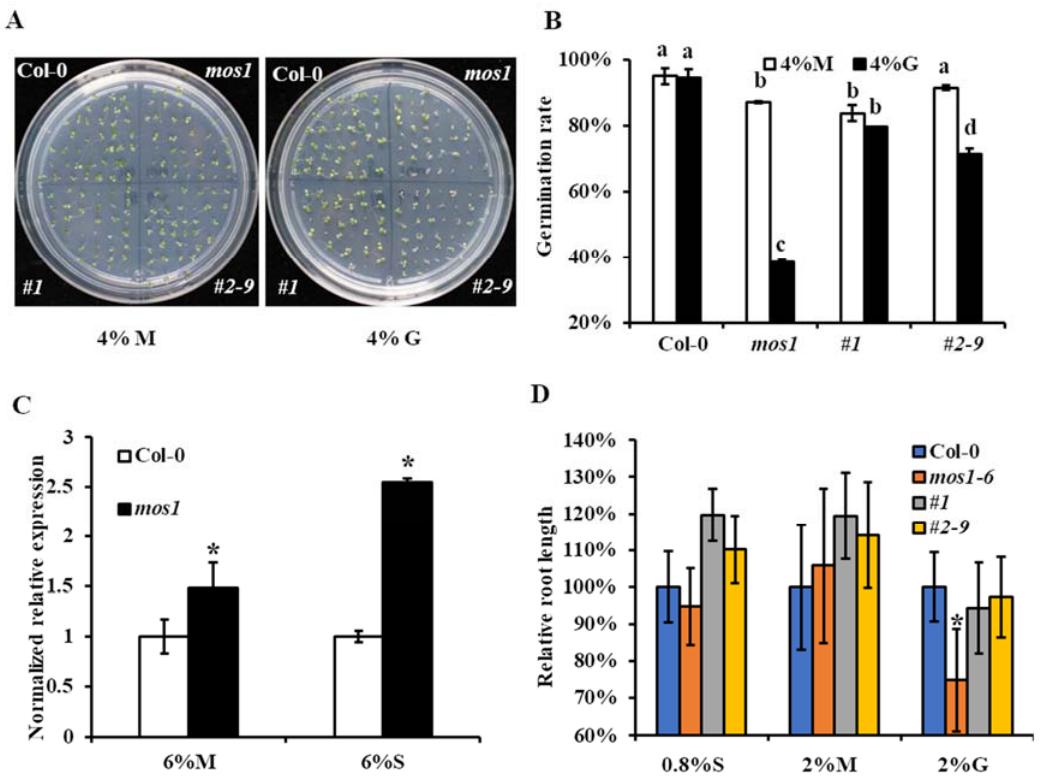
Figure 1. Hypersensitive phenotypes of mos1 in response to sugars. ( A ) Representative images of the germination of Col-0 and mos1 , #1 , and #2-9 grown on half-strength MS medium with 4% mannitol (M) or 4% glucose (G). ( B ) The germination rates of Col-0 and mos1 , #1 , and #2–9 grown on half-strength MS medium with 4% M or 4% G. Di ff erent letters above the bars indicate significant di ff erences (one-way ANOVA / Bonferroni p < 0.001). ( C ) qRT-PCR analysis of APL3 expression in Col-0 and mos1 seedlings grown on half-strength MS medium with 6% M or 6% S. Quantification was normalized to ACTIN2 . Error bars indicate standard error (SE) of two independent biological replicates. The asterisk indicates a significant di ff erence compared with the corresponding Col-0 (one-way ANOVA / Bonferroni p < 0.001). ( D ) Relative root lengths of 7-d-old Col-0 and mos1 , #1 , and #2–9 seedlings grown on half-strength MS medium with 0.8% sucrose (S), 2% M or 2% G.